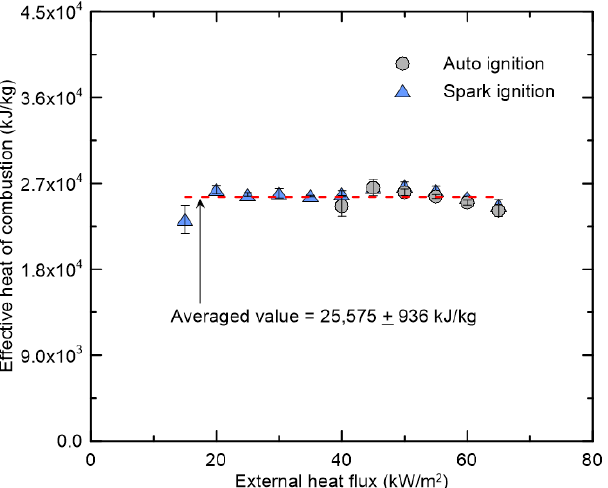
Figure 7. Effective heat of combustion as a function of external heat flux for the auto and spark ignitions.